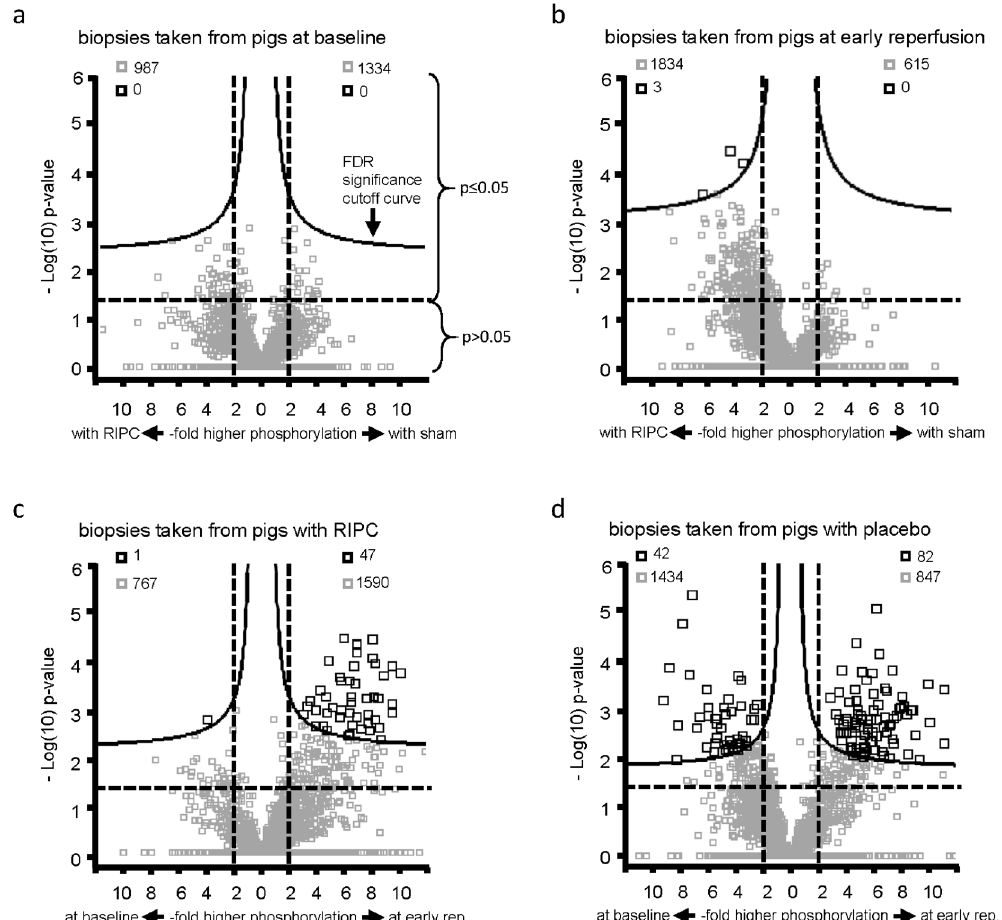
Figure 6. Vulcano plots of all detected phosphopeptides after phosphoproteome phosphopeptide enrichement of porcine left ventricular biopsies. Vulcano plots of − Log(10)p-value over -fold higher phosphorylation of all proteins between groups (remote ischemic preconditioning (RIPC)/sham) detected after phosphopeptide enrichment of porcine left ventricular biopsies taken ( a ) at baseline and ( b ) at early reperfusion. Vulcano plots of − Log(10)p-value over -fold higher phosphorylation of all proteins in the comparison between time points (baseline versus early reperfusion) ( c ) with remote ischemic preconditioning (RIPC) and ( d ) with sham. A − Log(10)p-value of ≥ 1.3 corresponds to a p-value of ≤ 0.05. The false discovery rate (FDR) significance cut-off curve indicates differences in protein phosphorylation between RIPC and sham at early reperfusion and between time points (baseline/early reperfusion) with RIPC and with sham, respectively. Grey squares: phosphopeptides without FDR-based statistical difference between RIPC and sham or between baseline and early reperfusion. Black squares: phosphopeptides with FDR-based statistical difference between RIPC and sham or between baseline and early